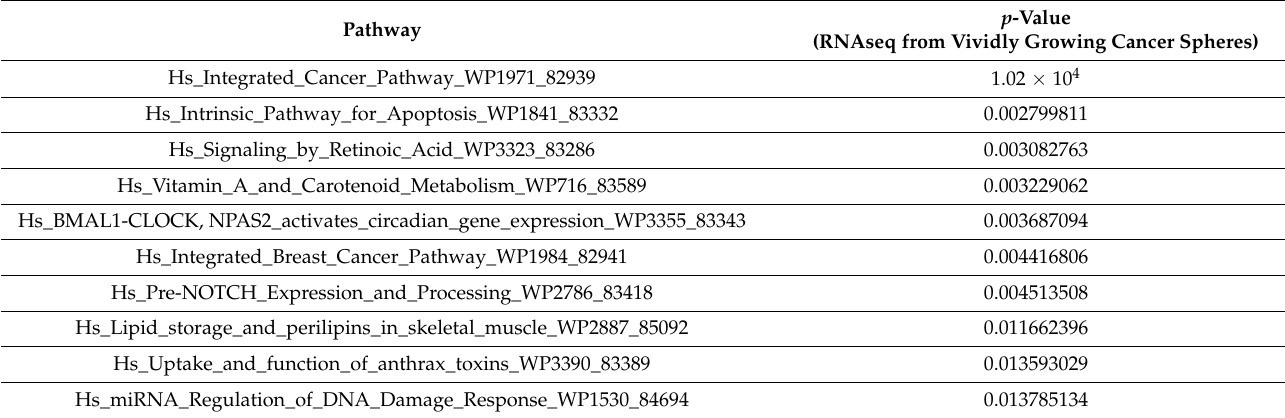
Table 2. Upregulated pathways in vividly growing cancer spheres.